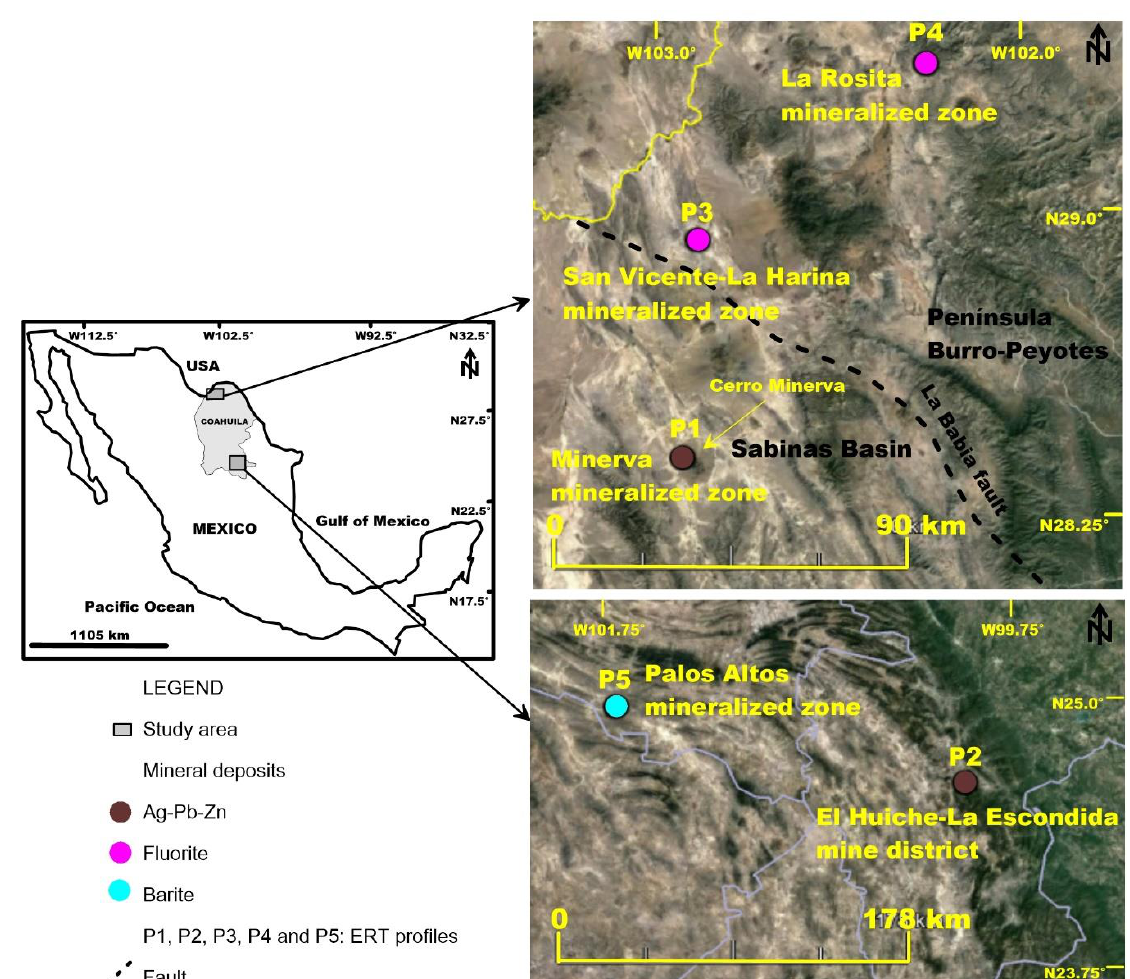
Figure 1. Location of the study area in northeast Mexico (Coahuila state). Profiles P1 and P4 are in magmatic deposits. Profiles P2, P3, and P5 are in MVT deposits. P1 is in the Minerva Mine, P2 in Guadalupe Mine, P3 in El Otomí mine, P4 in Juan Valencia mine, and P5 in El Tapón mine.